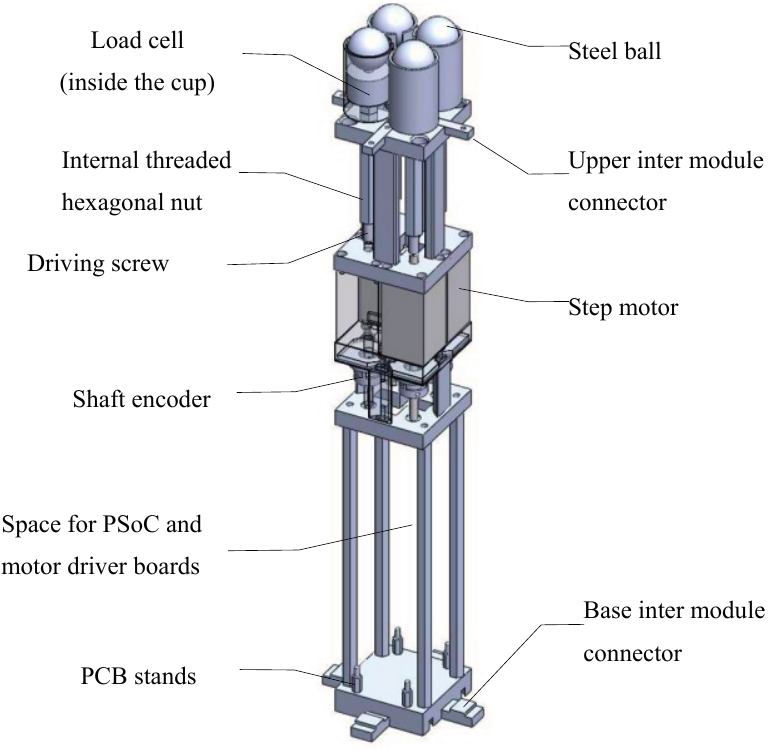
Figure 3. The mechanical design of a module unit in which threaded sleeves and driving rods form the retractable support